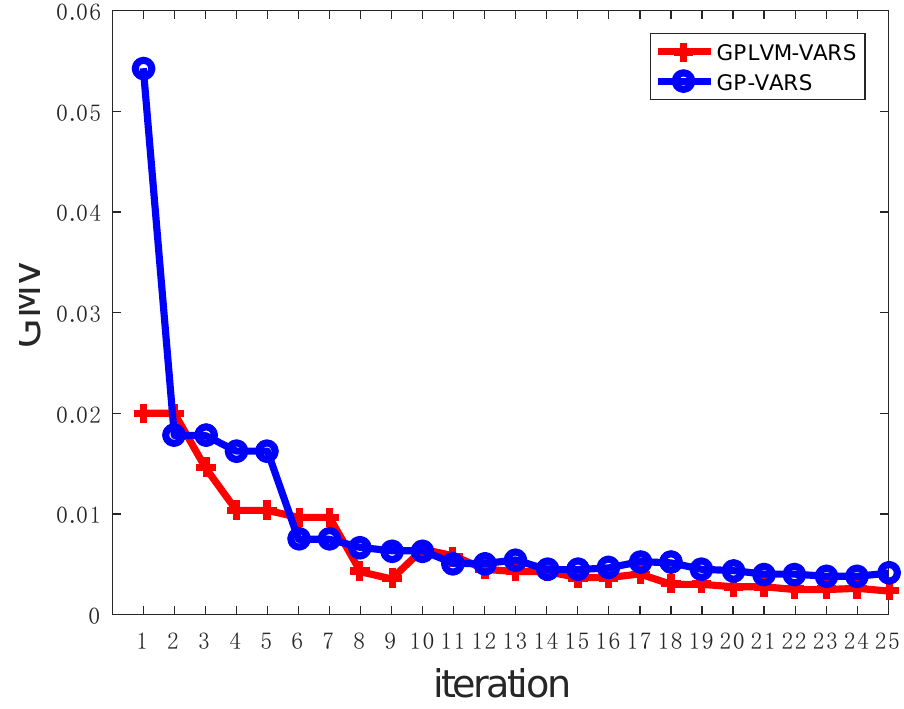
Figure 6. The comparison of GMVs based on GP-VARS and GPLVM-VARS.